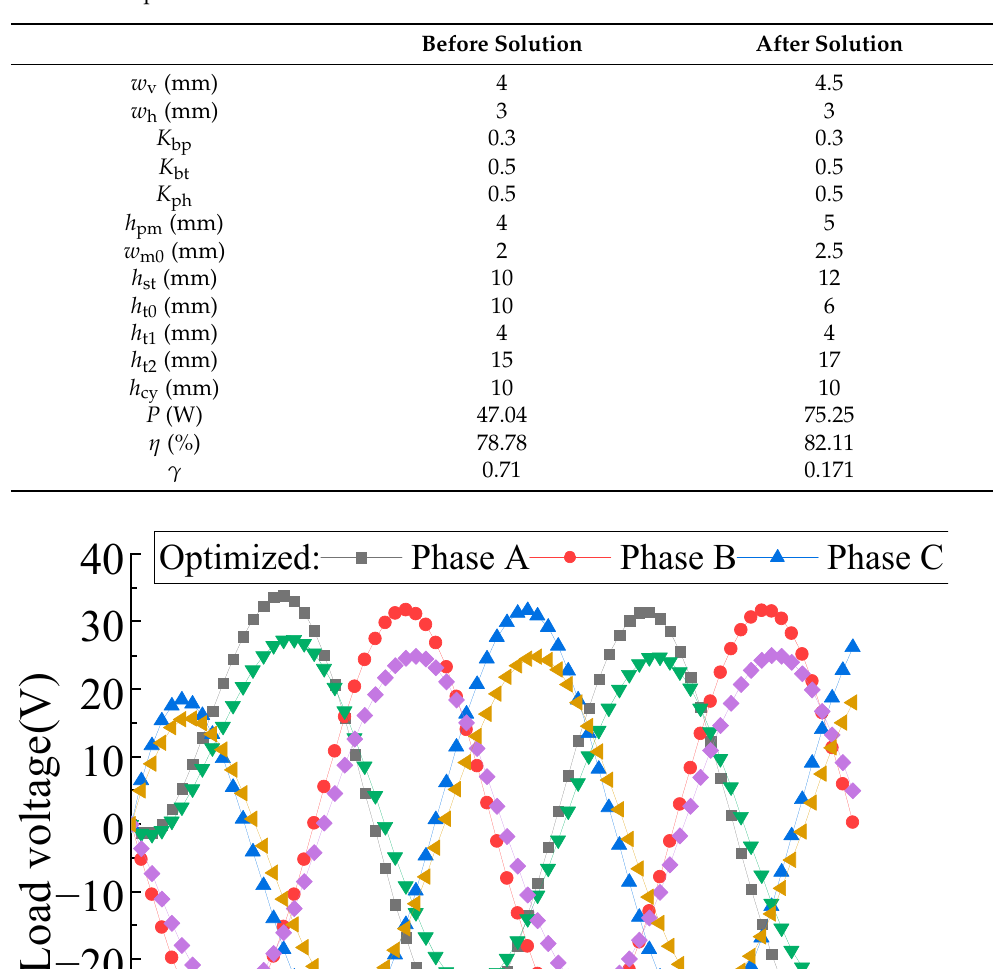
Table 8. Comparison results of the STMLPMVG.